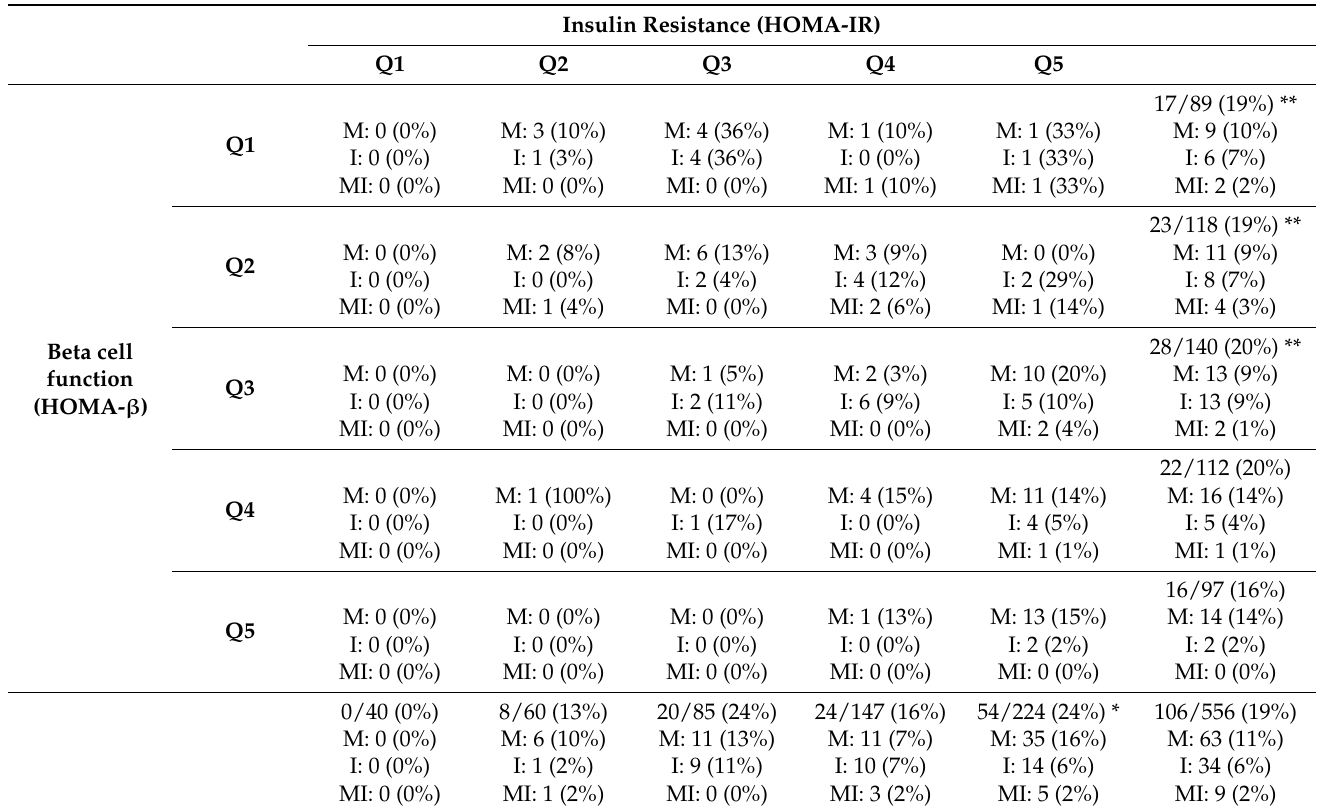
Table 4. Percentage of women with GDM who received medication as a function of insulin resistance and concomitant beta cell function.